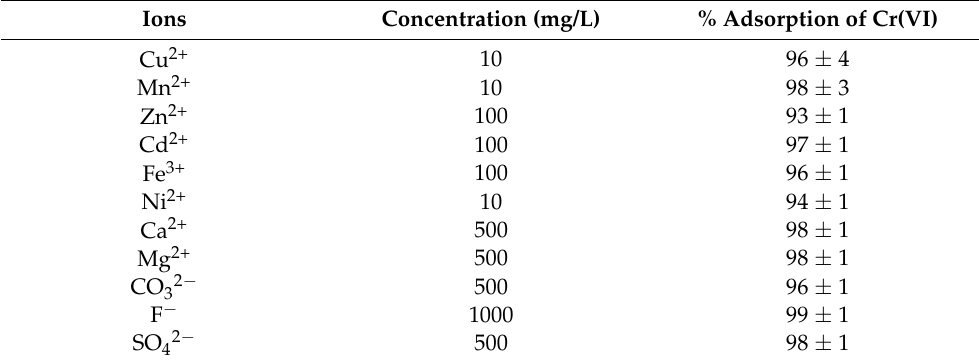
Table 5. Effect of interfering ions on the adsorption of Cr-VI ions over the MNPs/rGO/PMMA